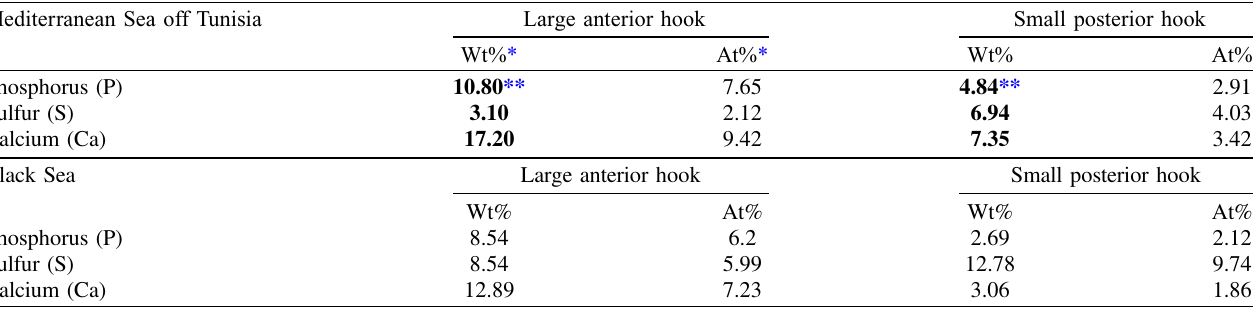
Table 3. Results of the X-ray microanalysis for elements present in the base of hooks of Neoechinorhynchus personatus from Mugil cephalus in two different geographical locations, the Mediterranean Sea off Tunisia and the Black Sea.